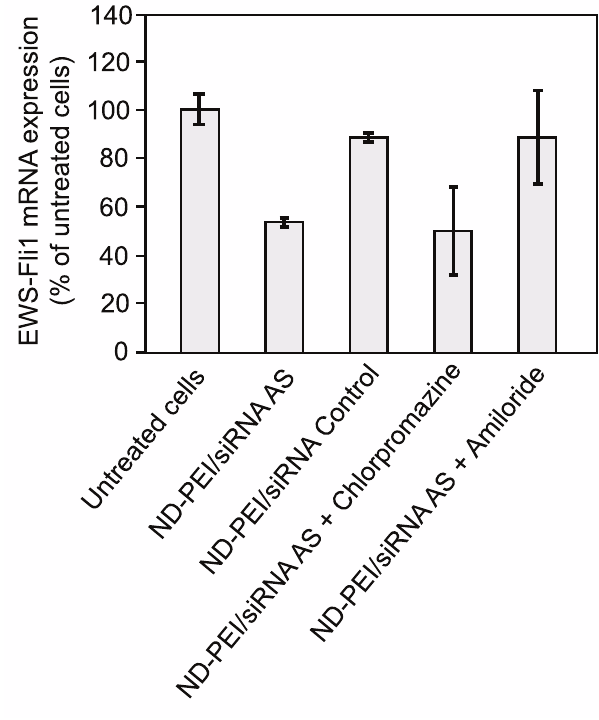
Figure 5. RT-qPCR analysis of EWS-Fli1 gene expression in NIH/ 3T3 EWS-Fli1 cells. The cells were treated with 50 nM antisense siRNA vectorized with ND-PEI at a mass ratio of 1:75, with or without drugs specifically inhibiting particular internalization pathways: chlor- promazine, blocking the clathrin pathway and amiloride, inhibiting the macropinocytosis pathway. EWS-Fli1 gene expression is normalized with respect to that of the 18S rRNA gene.